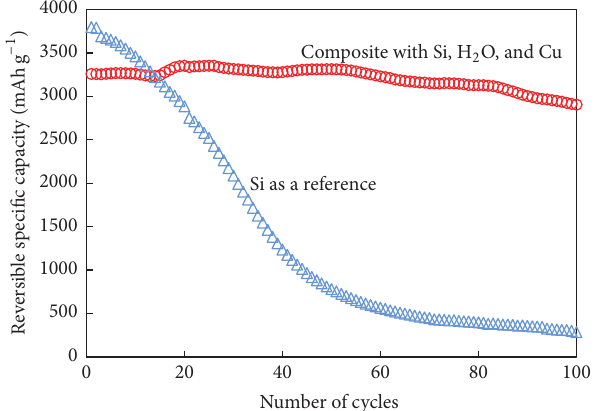
Figure 13: Change in initial coulombic efficiency with oxygen (as H 2 O) addition